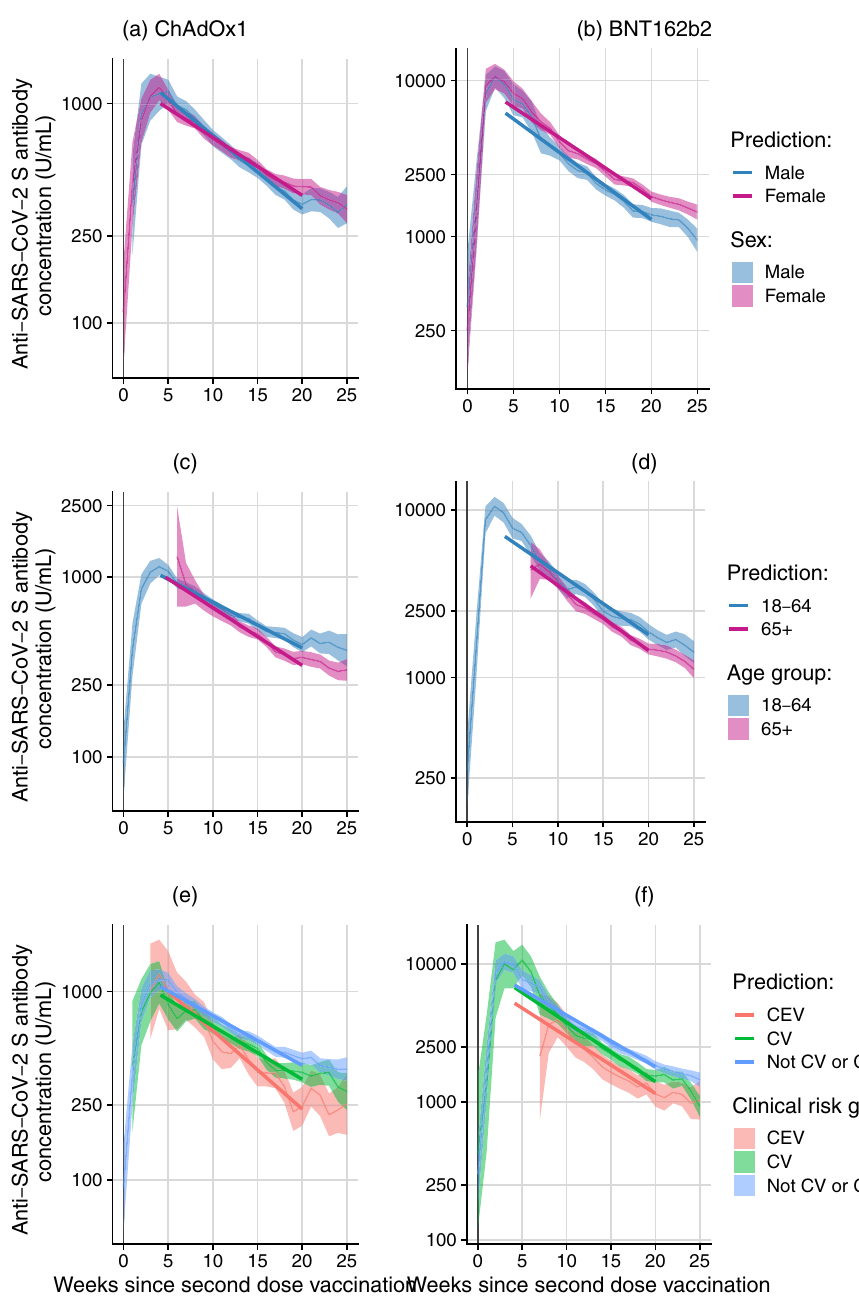
Fig. 2 | Geometric mean (with 95% con fi dence intervals) for anti-S samples (U/ ml)overtimesinceseconddoseofvaccination,andlevelspredictedbyalinear mixed effect model amongst N-seronegative individuals by vaccine type and sex, age and clinical risk group. (Note: Different y-axis scales for BNT162b2 and ChAdOx1). Twenty weeks after the second dose of vaccine, mean BNT162b2 anti-S levels were 1875 (95% CI: 1686 – 2085) U/ml in 18 – 64 year olds and 1479 (95% CI: 1373 – 1593) U/ml in participants over 65 years of age (Fig. 2). Anti-S levels